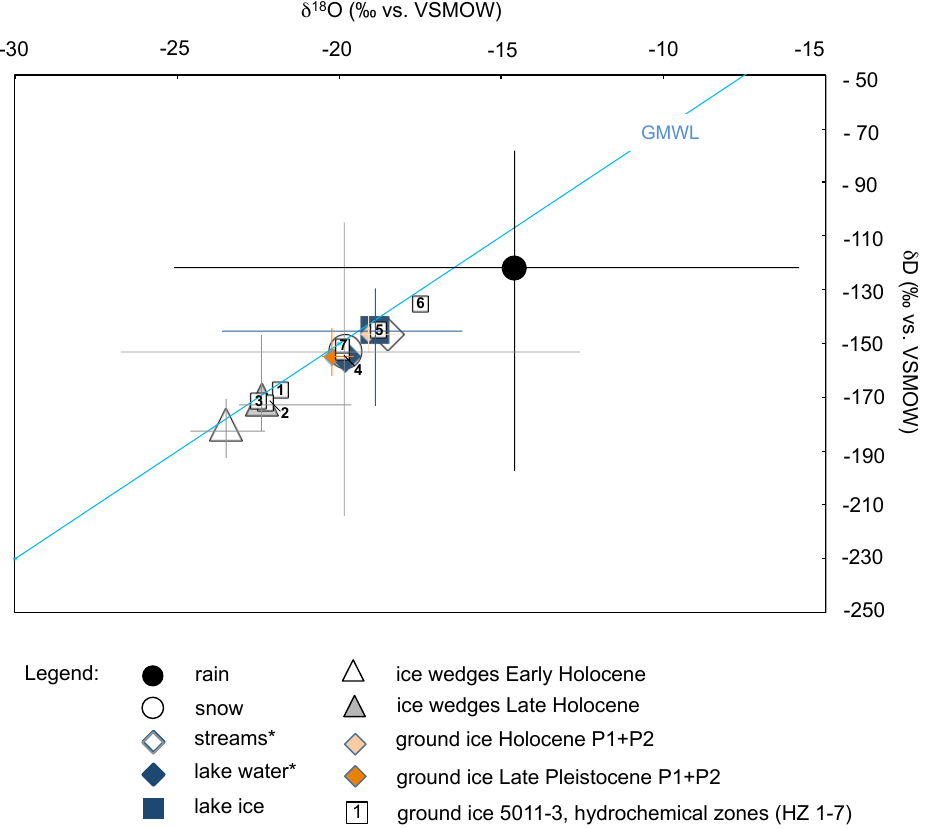
Figure 6. Stable isotope composition of 5011-3 ground ice, which is subdivided into the seven hydrochemical zones (HZs) as discussed in the text. Other H 2 O sample sets from the El’gygytgyn crater are displayed for comparison with mean values and min. to max. ranges; GMWL (global meteoric water line) after Craig (1961); ∗ data from Wilkie et al.